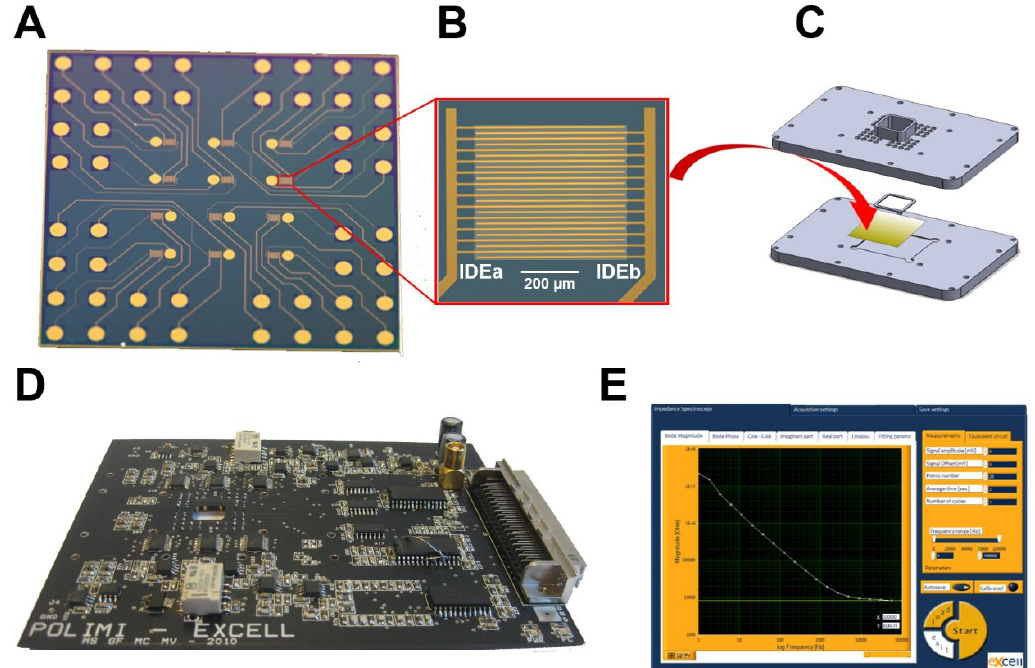
Figure 1. Impedance measurement setup: A ) Microelectrode array chip with 12 IDEs; B ) zoom-in view of one IDE (the ca. 500 µm x 500 µm opening in the silicon nitride passivation layer appears as a lighter region in the center) ; C ) chip holder (the lower plate accommodates a MEA chip and the upper plate provides the 600 μ l cell culture chamber and an array of holes for electrical connections using spring-loaded pins; fluid tight sealing on the MEA chip is achieved by using a laser cut silicon rubber gasket); D ) Printed circuit board (PCB) of the custom-made 12-channel bipotentiostat (the PCB has an opening to the cell culture vial of the chip holder to allow liquid handling and microscopic visualization; E ) user interface of the data acquisition software showing recorded impedance magnitude vs. log